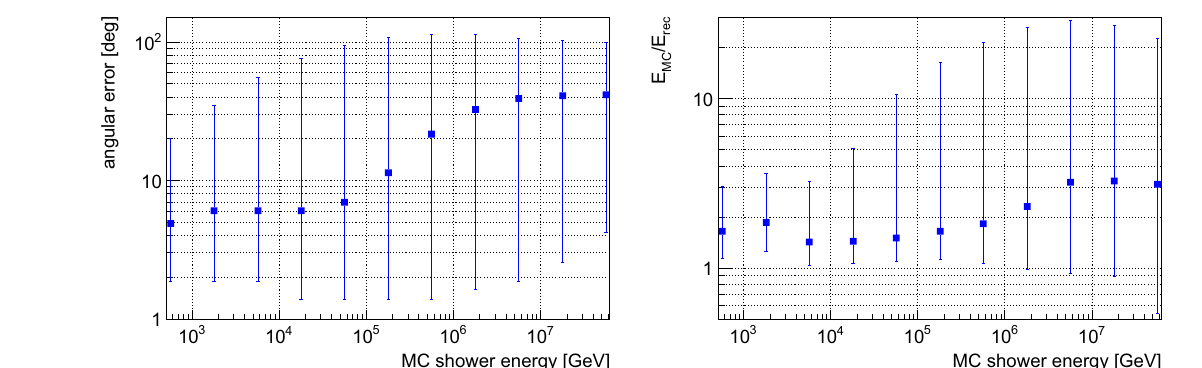
the MC shower energy. Blue squares denote the median of the distri- butions. The lower and upper end of the vertical bars in both figures show the 10 and 90% quantiles of the distributions,